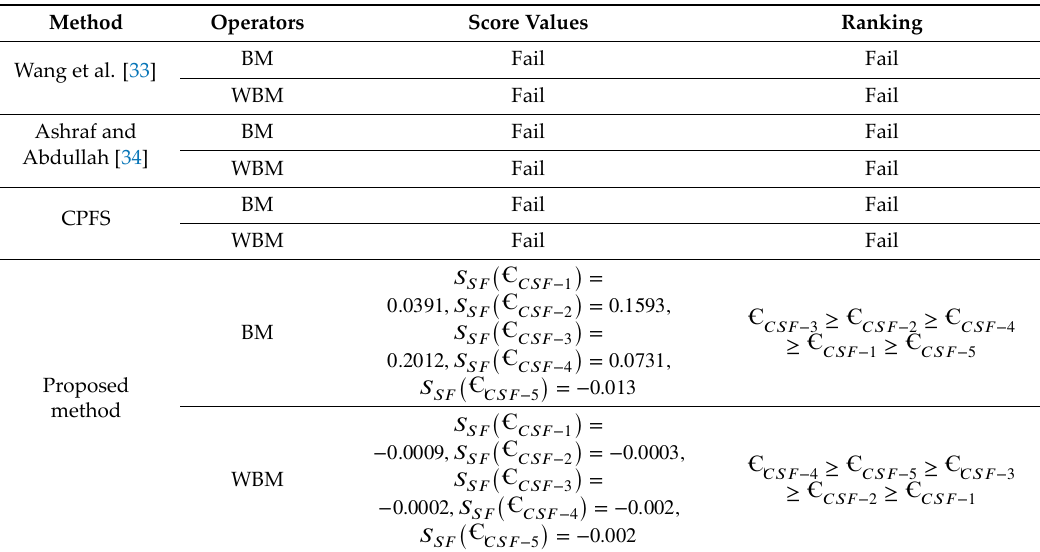
Table 3. Comparative analysis for the information in Table